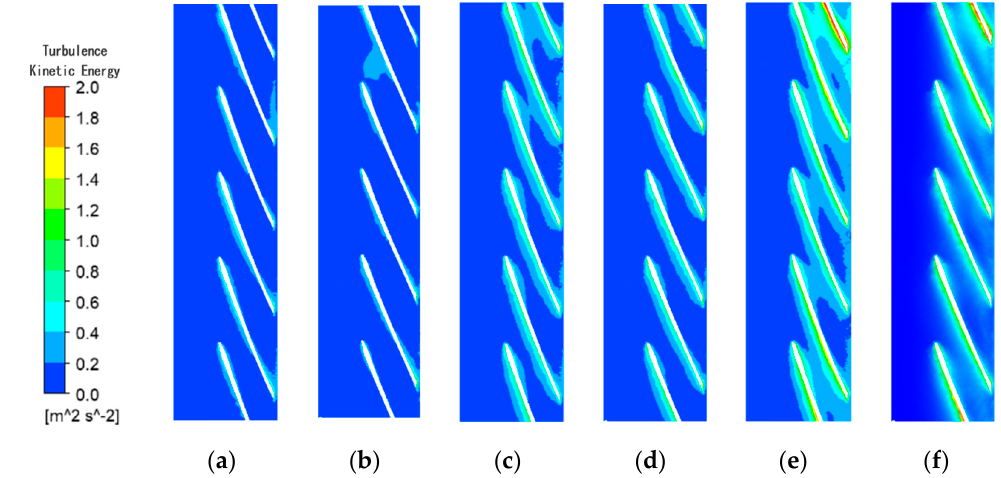
Figure 12. Turbulence kinetic energy distributions in blade-to-blade view at 0.8 l span of original pump and optimal pump. ( a ) original impeller at 0.6 Q d , ( b ) optimal impeller at 0.6 Q d , ( c ) original impeller at 1.0 Q d , ( d ) optimal impeller at 1.0 Q d , ( e ) optimal impeller at 1.5 Q d , and ( f ) original impeller at 1.5 Q d .